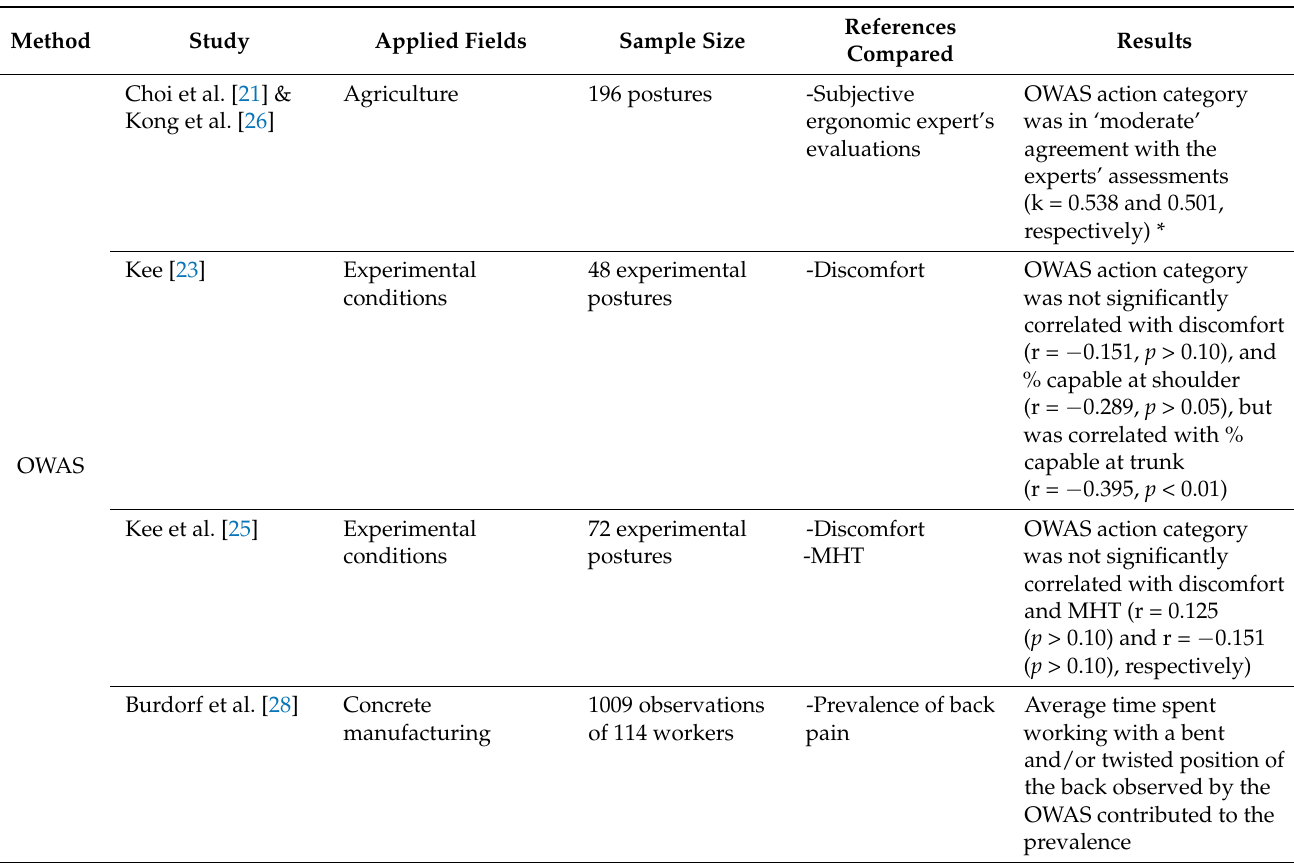
Table 6. Validations by